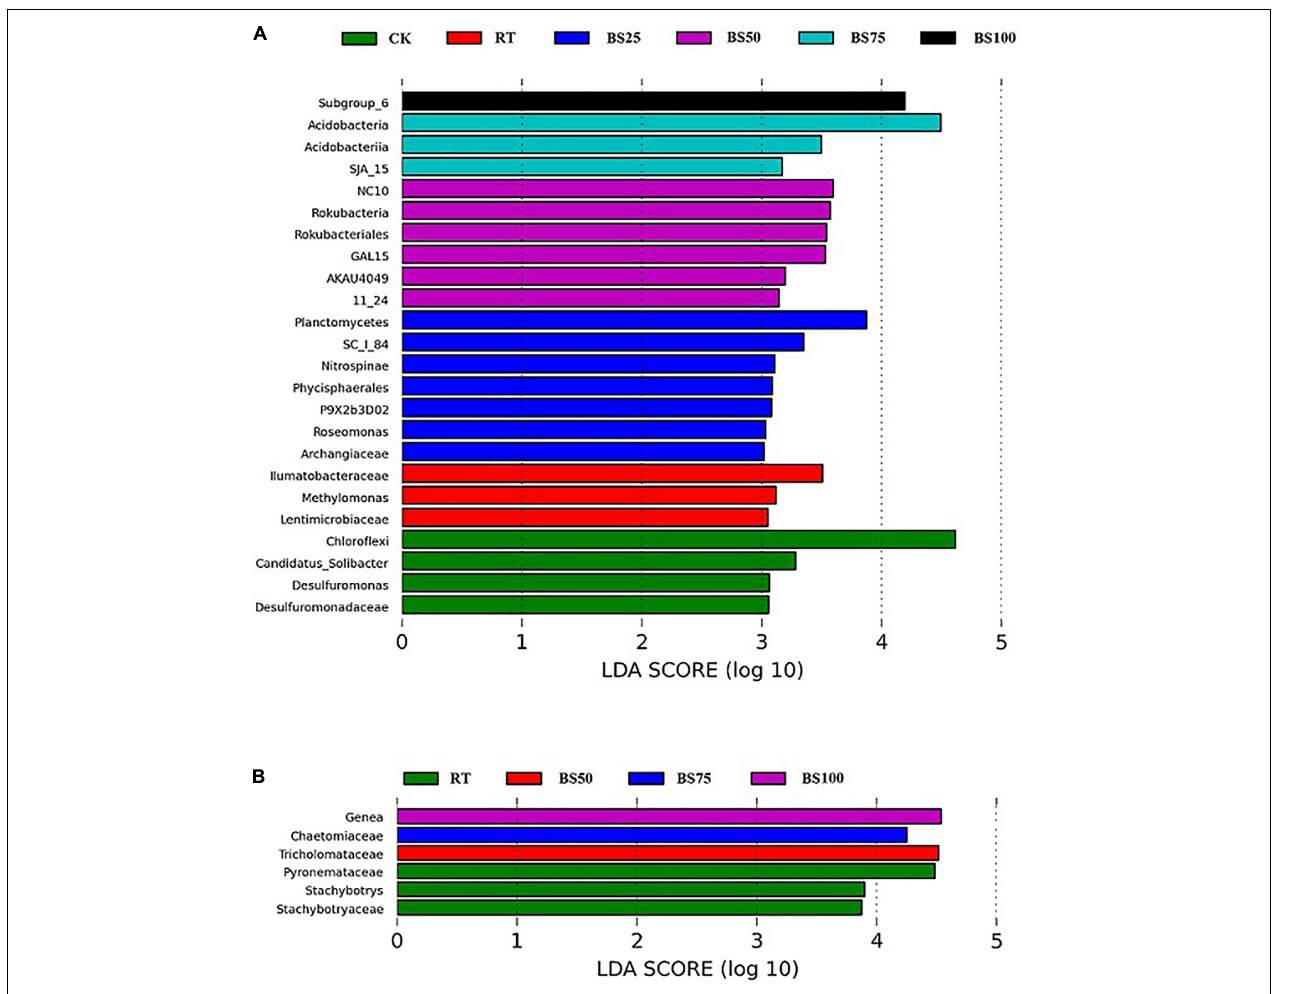
FIGURE 3 | LEfSe analysis of the most differentially abundant bacterial (A) and fungal (B) taxa in the soil samples (LDA score >